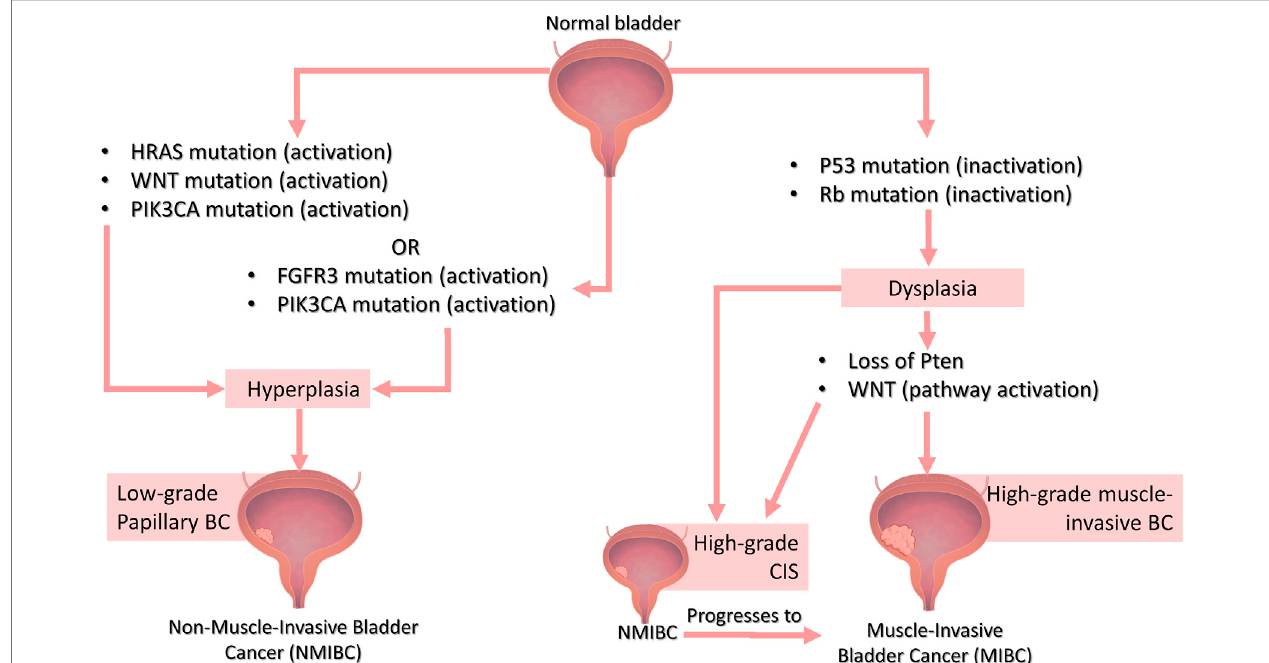
FIGURE1| ThegeneticbasisofBladderCancer.Distinctgeneticpathwaysareinvolvedinthedevelopmentofmuscle-invasiveornon-muscleinvasiveBC.NMIBC can be sub-classi fi ed into low-grade, which are mainly super fi cial (papillary) tumors that grow into the bladder innermost layers but do not invade the muscle layer, and high-grade,whichincludeasubsetofsuper fi cialtumorsaswellascarcinoma insitu (CIS),whicharecharacterizedbya fl attenedlayerofdysplasticcellsthatispresumed to be the major precursor of muscle-invasive bladder tumors. NMIBC low-grade papillary lesions are frequently associated with either activating mutations in RAS (usually the H-Ras isoform) or FGFR3 gene (these mutations are mutually exclusive, meaning that they do not occur together). On the contrary, FGFR3 and PIK3CA mutationsusuallyco-occurinNMIBC.TheWntpathwaycanalsobeinvolvedinNMIBCwhenincombinationwithRASpathwayactivation.InMIBClesions,asthename suggests, the cells invade the adjacent muscle layer of the bladder and, in some cases, progresses to metastatic tumors. The most commonly found mutations in high- grade lesions such as non-muscle-invasive CIS or MIBC are loss of p53 and RB function. Loss of PTEN function and activation of the Wnt signaling pathway are also related to high-grade tumors especially MIBC. Bladder image obtained from Biorender (https://biorender.com/)